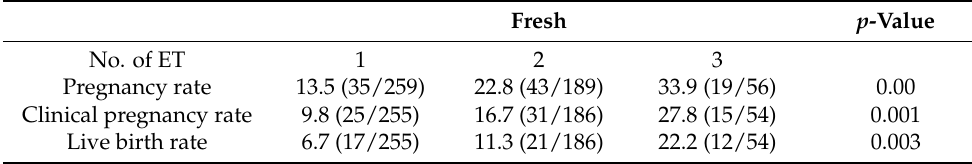
Table 3. Comparison of IVF outcomes depending on the numbers of ET in fresh cycle. Fresh p